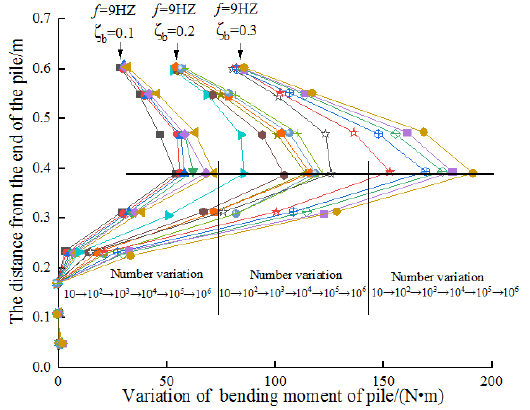
Figure 9. Variation of bending moment of pile.